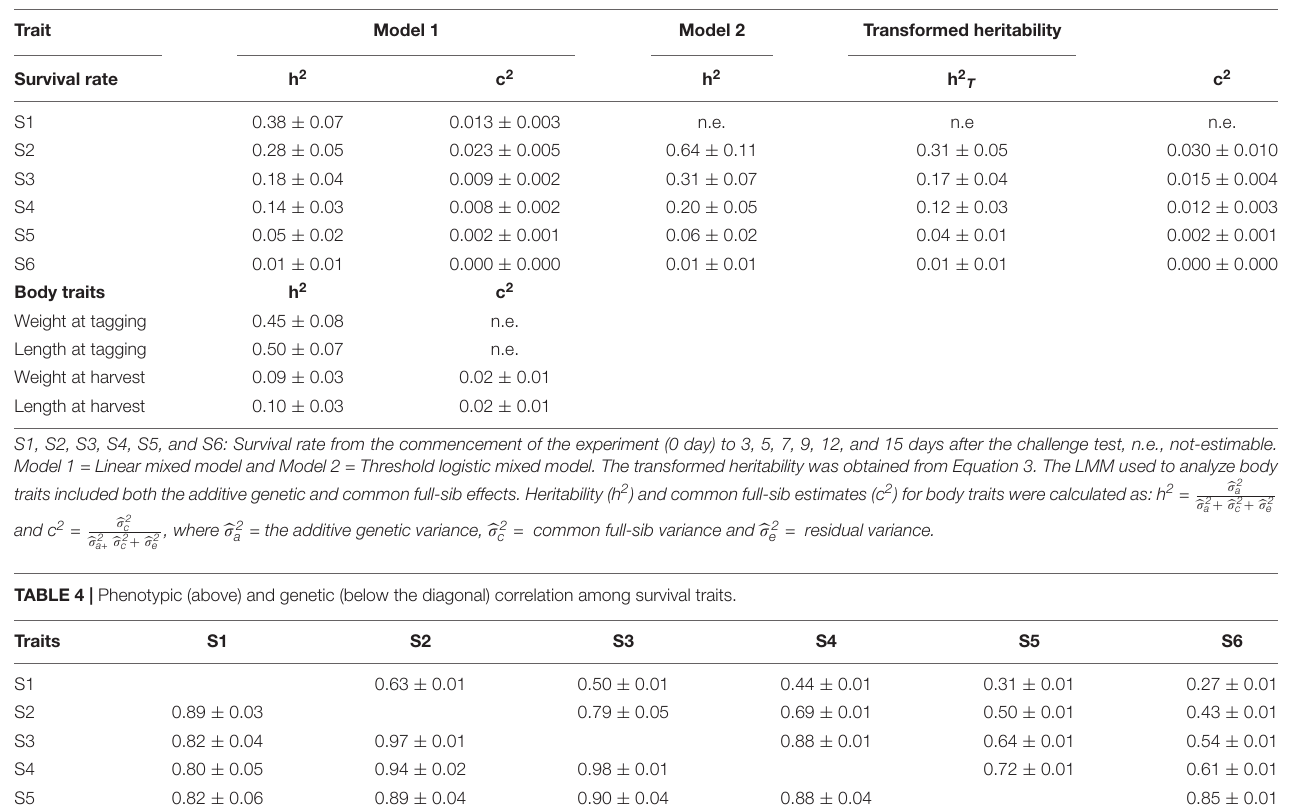
TABLE 5 | Genetic (r G ) correlation between body weight and survival rate. Traits Weight at